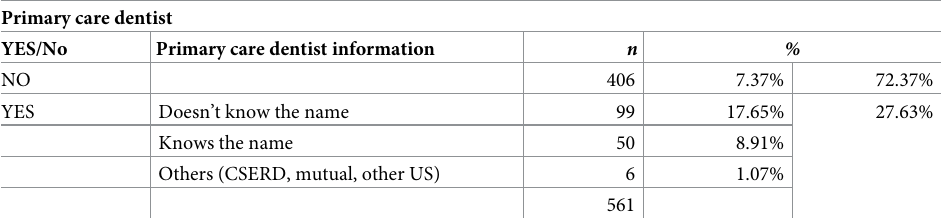
Table 4. Numbers of inmates reported having a primary care